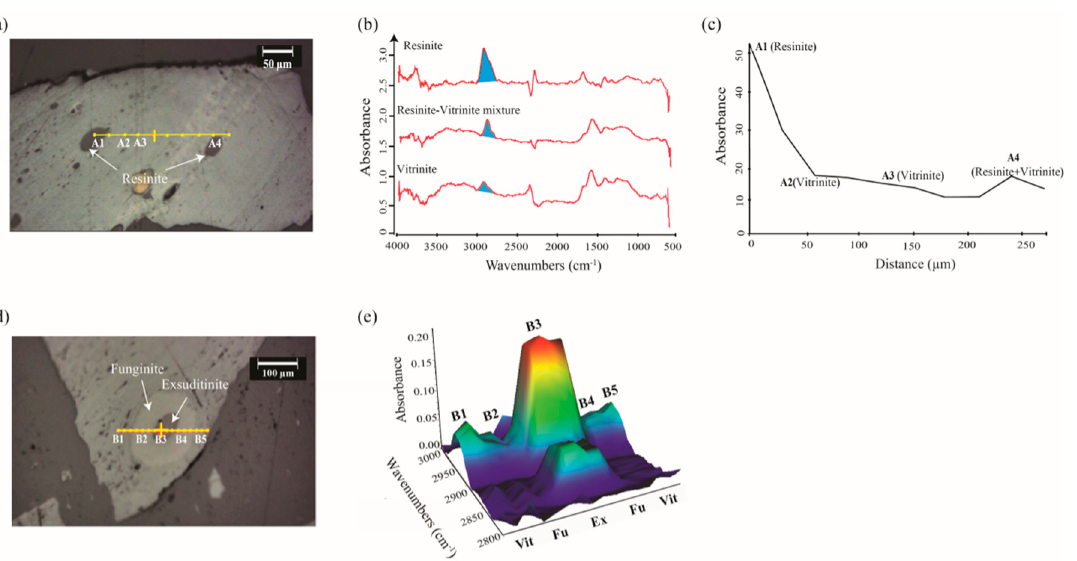
Figure 3. Chemical mapping of vitrinite, resinite, funginite, and exsudatinite in coal samples. ( a ) Photomicrograph of the sample in reflected light showing the location of transect A indicated by yellow dots. The sampling points are evenly distributed along the transect. The sampling area at point A1 contains pure resinite, and points A2 and A3 represent pure vitrinite (Vit). The sampling area at point A4 covers half resinite and half vitrinite; ( b ) FTIR spectra of resinite, vitrinite, and a resinite-vitrinite mixture. The blue-filled areas show how the absorbance plotted in panel ( c ) are defined. ( c ) the integrated area of aliphatic CH x stretching at 3000–2800 cm − 1 as a function of distance from point A1 . The aliphatic character is strongest in resinite (point A1 ), decreases toward vitrinite (points A2 and A3 ) and increases in the approach to point A4 that receives a mixed signal from both vitrinite and resinite; ( d ) Photomicrograph of the sample in reflected light showing the location of transect B (yellow dots) through a funginite (Fu) maceral; points B 1 and B 5 are in the adjacent vitrinite; points B2 and B4 are on the exterior funginite rim; point B3 is on the exsudatinite (Ex) impregnation; ( e ) An alternative way of showing the variation in FTIR-spectral absorbance of aliphatic CH x stretching bands at 3000–2800 cm − 1 across transect B (shown in d ) through funginite into adjacent vitrinite. Units in panels c and e are arbitrary absorbance units (AU). Modified after figures 4 and 8 in Chen et al. [38] with copyright permission from John Wiley and Sons.